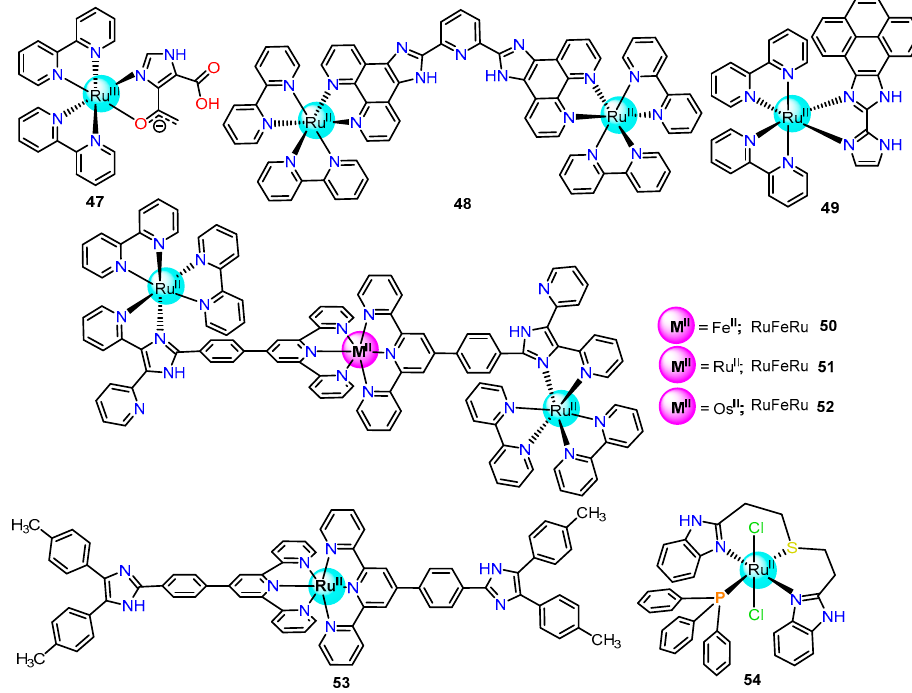
Figure 8. Structures of imidazole-based Ru(II) complexes 47 – 54.